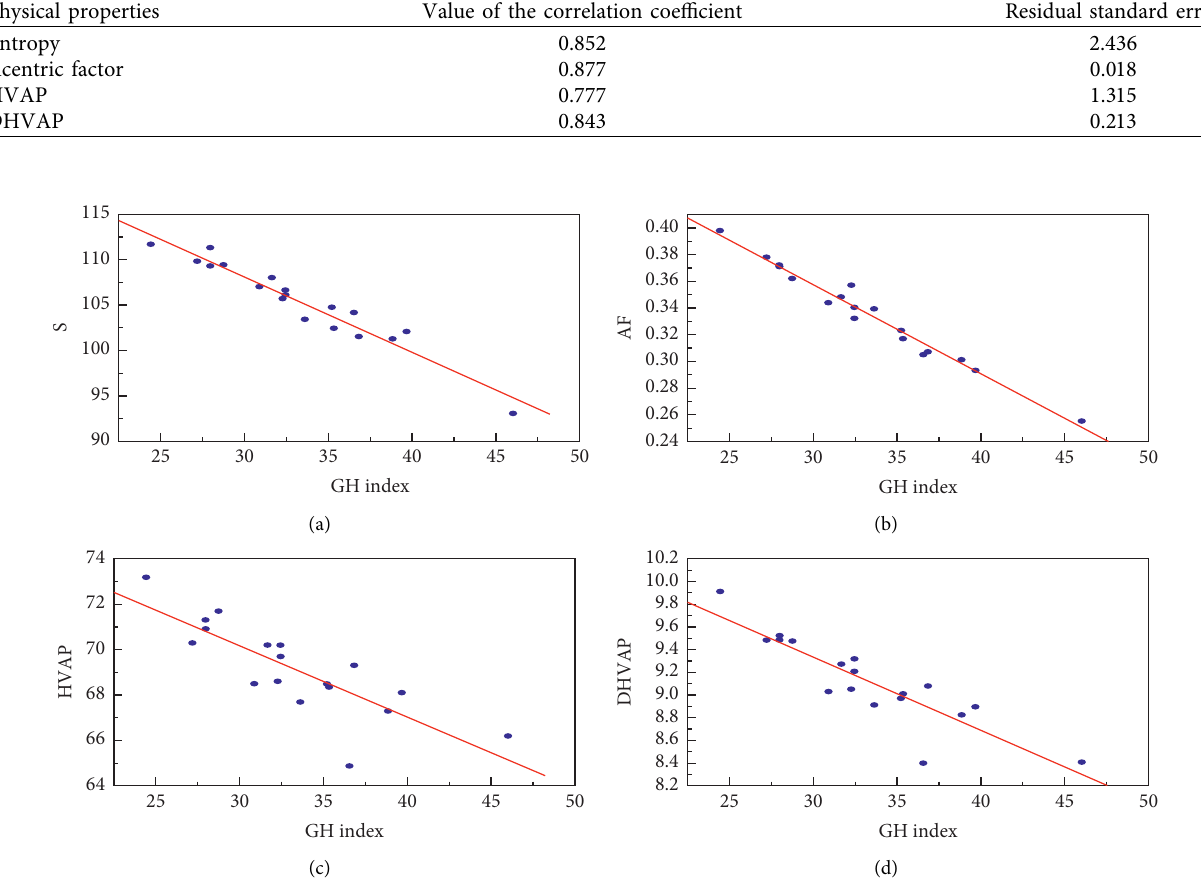
Figure 2: Scatter diagram of physical properties S , AF, HVAP, and DHVAP with the GH